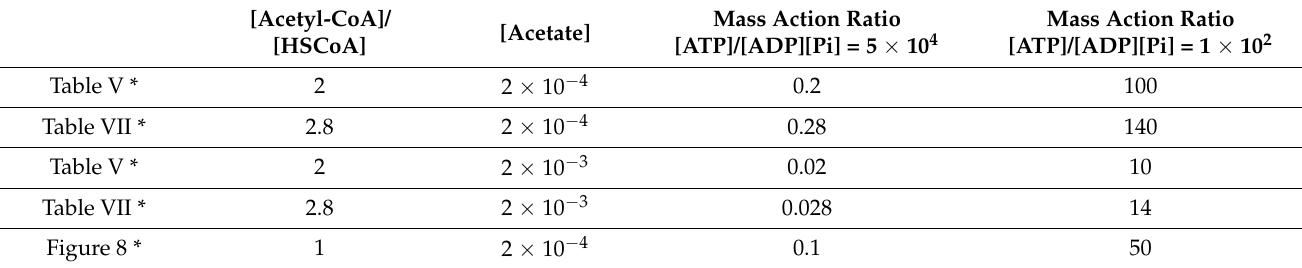
Table 2. Inferring the intramitochondrial [ATP] f /[ADP] f [Pi] f using the acetate-CoA ligase reaction.